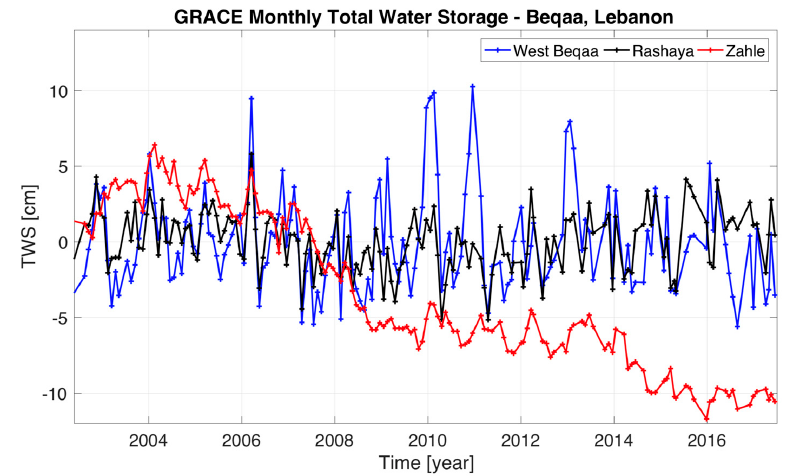
Figure 2. Total Water Storage (TWS) from the GRACE satellite data record. Three separate regions are shown, and the Zahle District is an area that is experiencing significant loss of water storage.